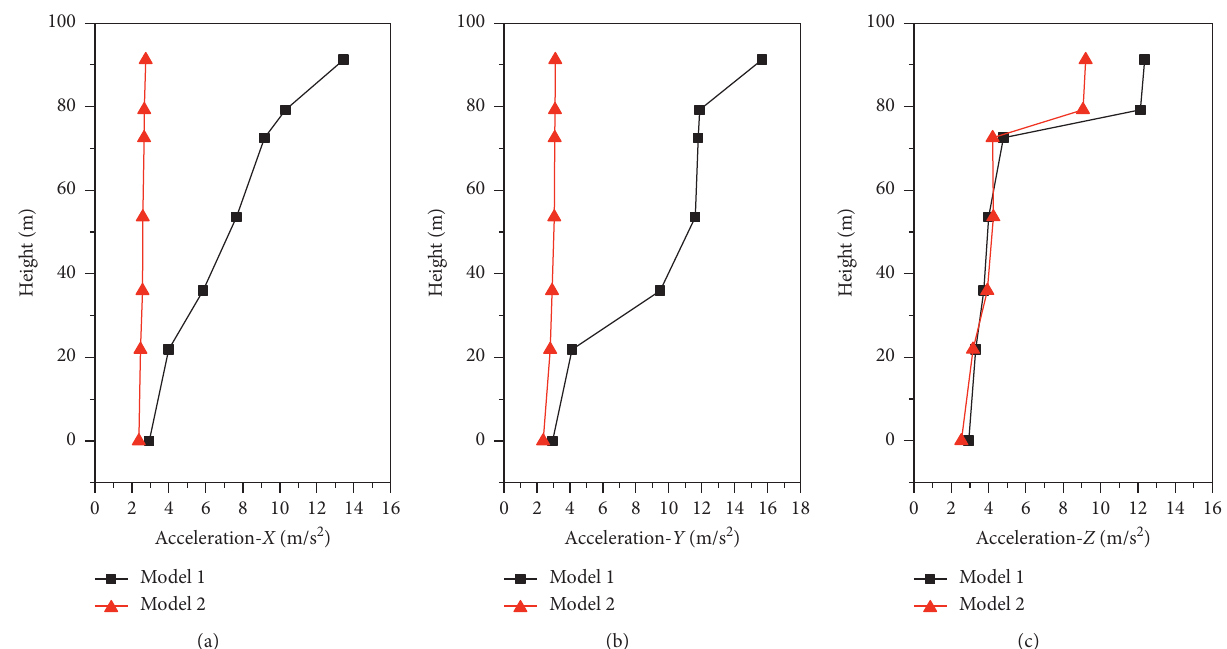
Figure 9: Comparison of peak acceleration along the height of structure: (a) X -direction, (b) Y -direction, and (c) Z